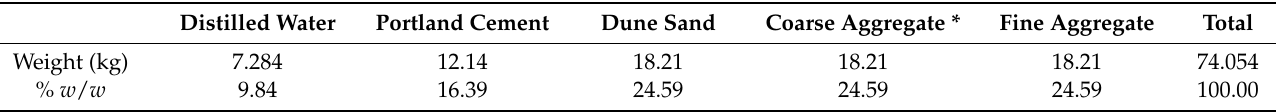
Table 1. Proportions of concrete mixture.